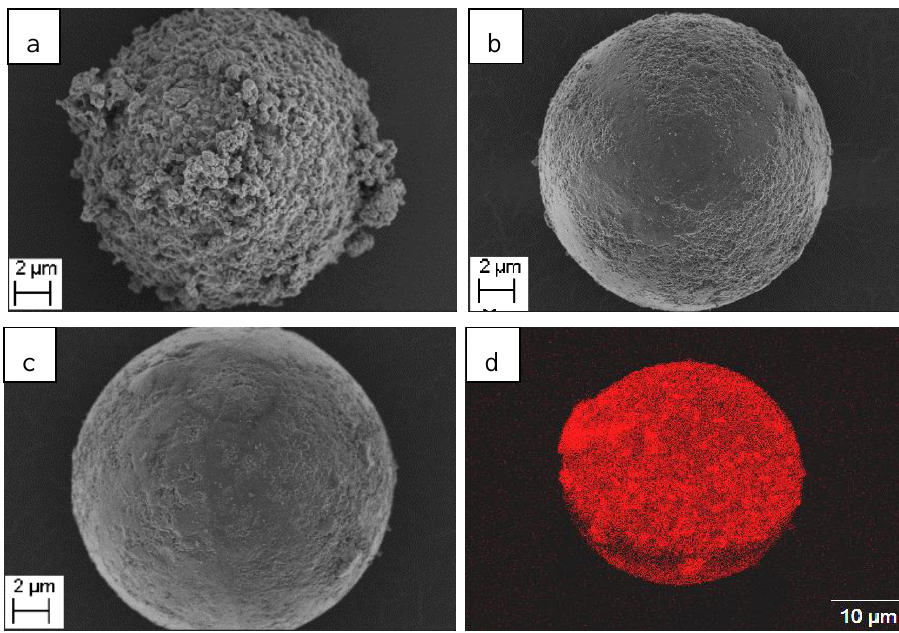
Figure 4. SEM images of Type S spheres coated via LPD-process (Experiment 1, 10 g) at different coating times: ( a ): 120 min; ( b ): 240 min; and ( c ): 300 min. As the coating time increase, the aluminum coating morphology becomes smoother due to the reaction process and the influence of the magnetic stir bar; ( d ) EDX-Mapping of a coated sphere Type S.